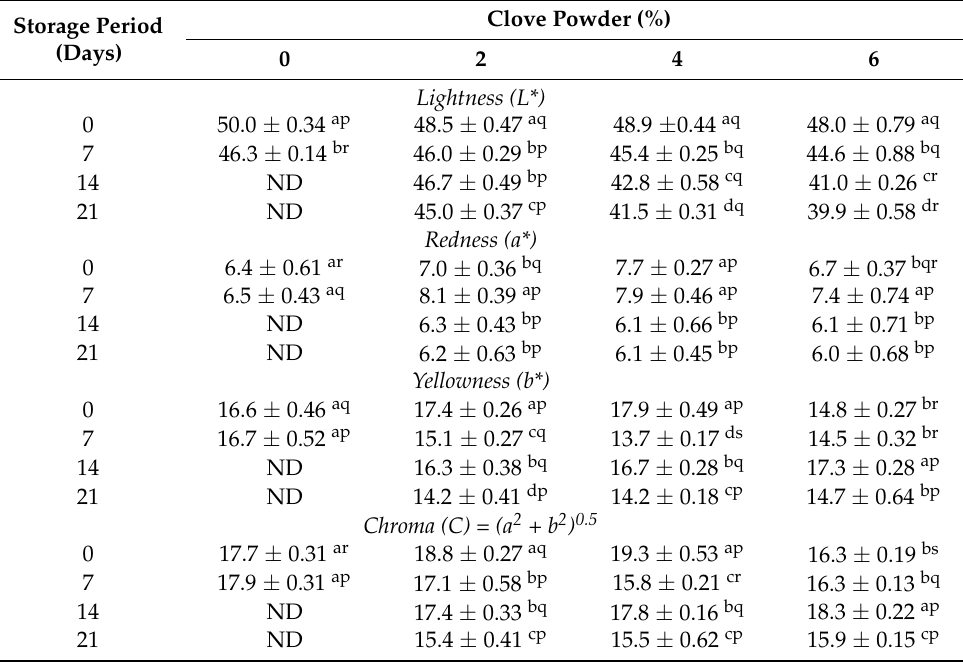
Table 4. Color characteristics of raw beef burger formulated with different concentrations of clove powder during storage at 4 ◦ C ( ±